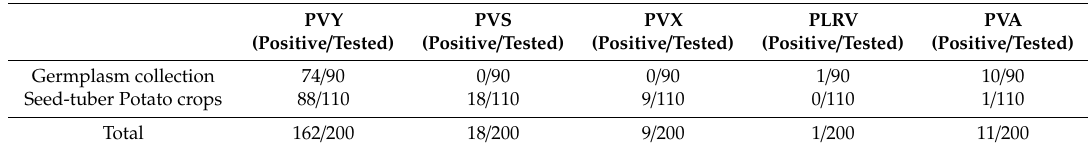
Table 1. Viruses detected by multiplex RT-PCR in plant samples collected from the diverse collection of potato germplasm and from seed-tuber potato crops. Samples were tested as described in Du et al. [55] for the presence of potato virus Y (PVY), potato virus S (PVS), potato virus X (PVX), potato leafroll virus (PLRV) and potato virus A (PVA). PVY PVS PVX PLRV (Positive / Tested) (Positive / Tested) (Positive / Tested) (Positive / Tested)